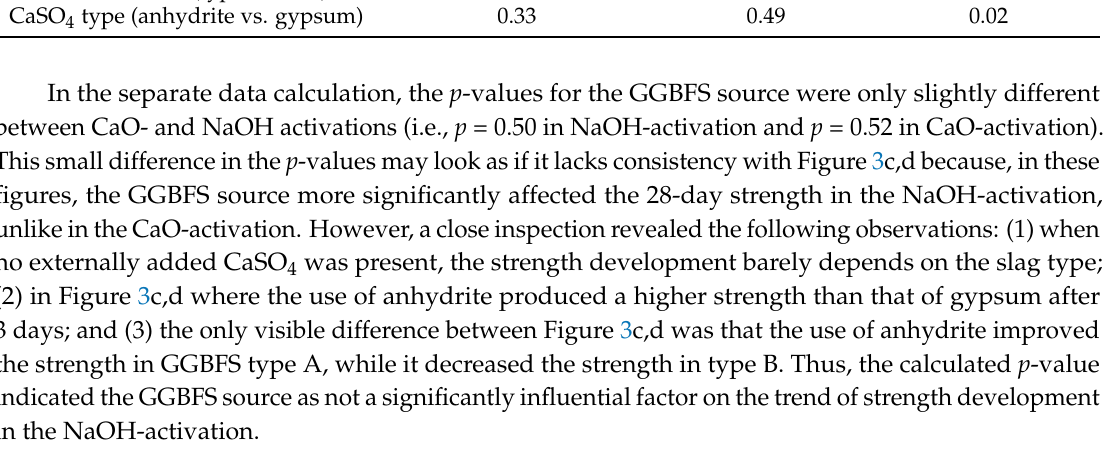
Table 3. Calculated significance levels ( p -values) of the explanatory factors from the factorial design using ANOVA. Explanatory Factor Entire Data Calculation Activator type (CaO vs. NaOH) 0.00 - - GGBFS source (type A vs. B) 0.47 CaSO 4 type (anhydrite vs.